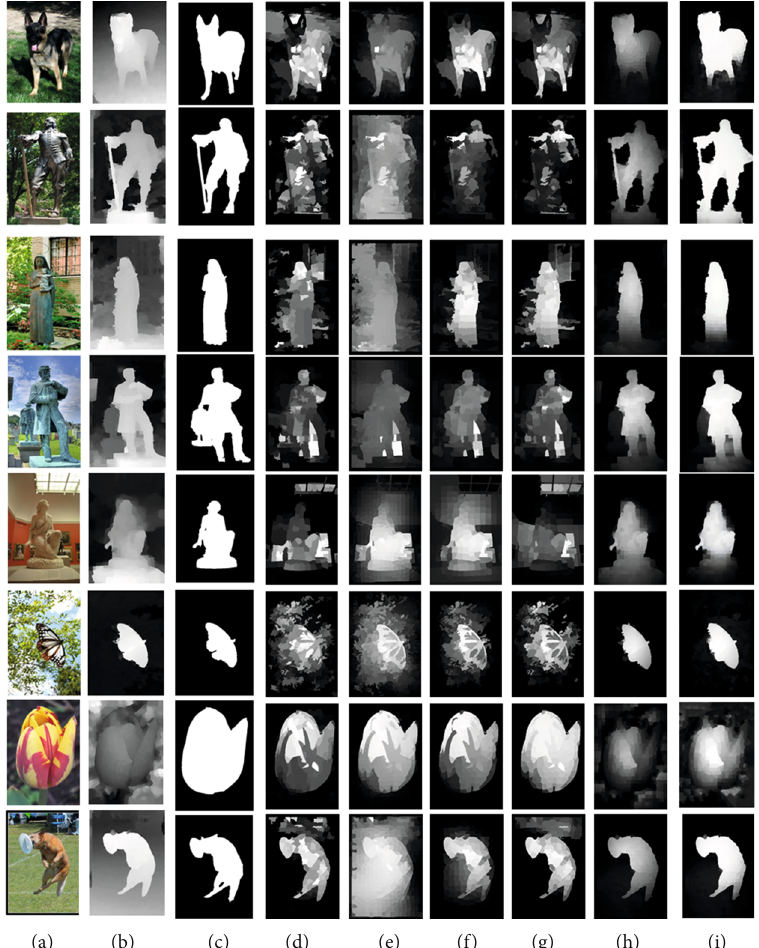
Figure 3: Saliency comparisons of di ff erent methods in terms of NJU400 dataset: (a) RGB image; (b) depth image; (c) ground truth; (d) GS; (e) MC; (f) MR; (g) WCTR; (h) ACSD; (i)